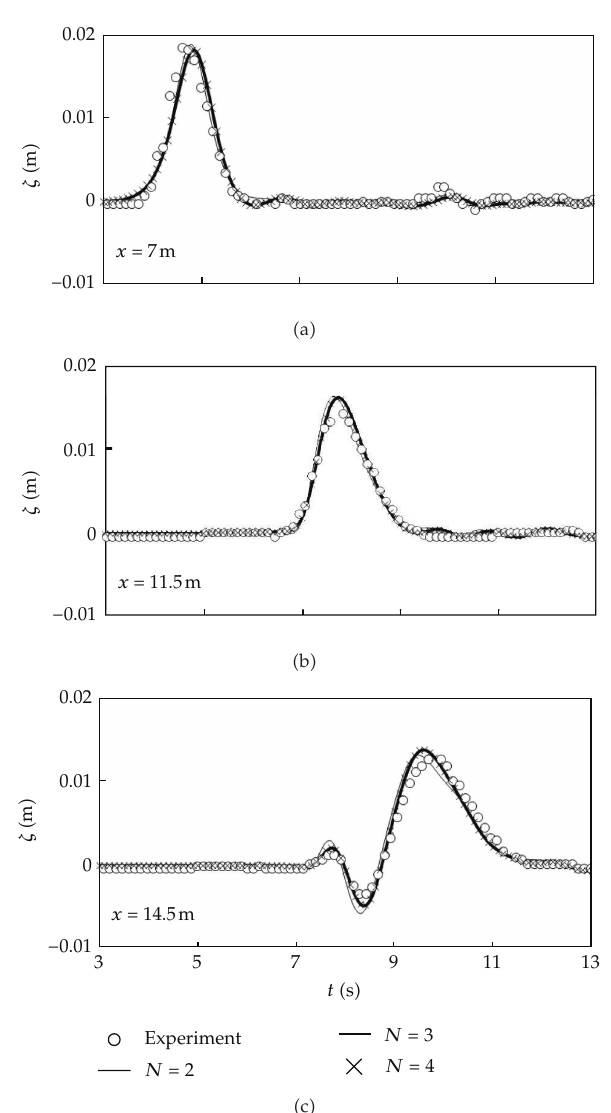
Figure 6: Surface displacements ζ at each point in one of the experimental cases by Sakai et al. (cid:5) 3 (cid:6) . The still water depth and incident wave height are 0.2m and 0.02m, respectively. The flexural rigidity of thin plate is 450.0Nm 2 . In the computation, the number of terms for velocity potential, N , is equal to 2, 3, or 4.